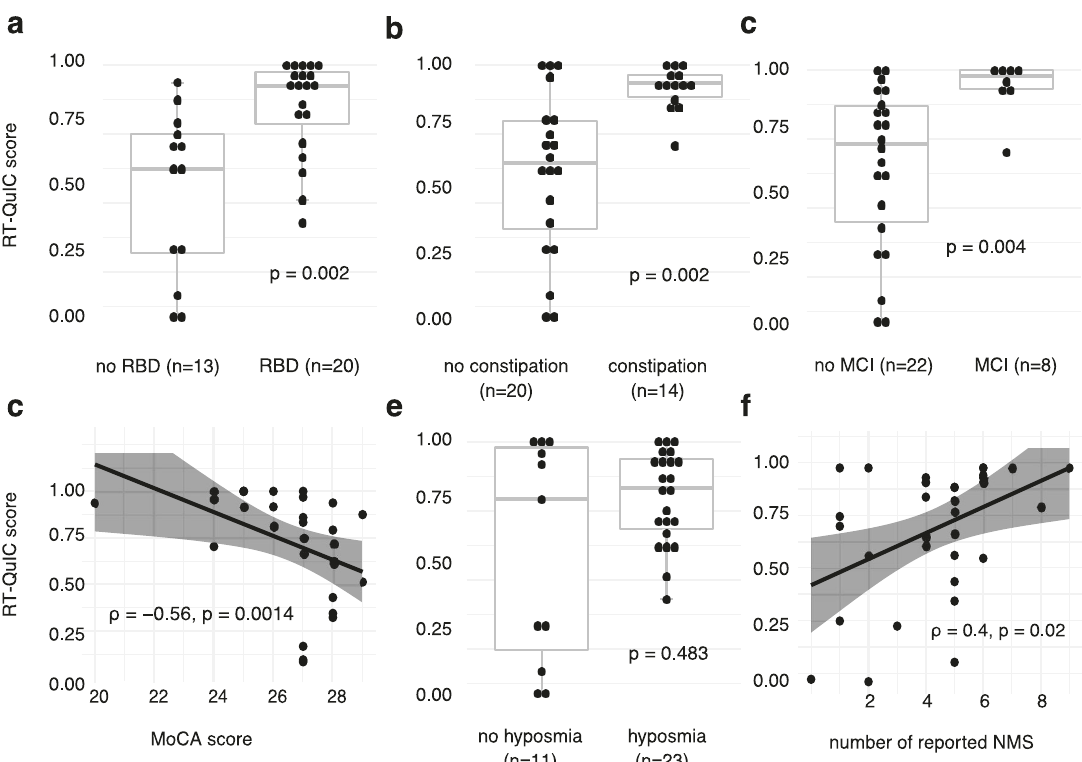
Fig. 6 Skin RT-QuIC scores correlate with non-motor symptom burden. a – c , e Box plots illustrating differences in skin RT-QuIC scores between subgroups reporting certain non-motor symptoms. Skin RT-QuIC scores (vertical axis: 0 – 1) pooled from both centers are higher in patients with possible RBD ( a ), constipation ( b ), and MCI ( c ). The skin RT-QuIC scores are not signi fi cantly higher in patients reporting hyposmia ( e ). The boxes represent the interquartile range (IQR), the middle line of each box indicates the median value with the median line and the whiskers extending to the most extreme data point, which is no more than 1.5 times of IQR. Values of individual patients are illustrated by dots. d , f Scatter plots illustrating correlations of skin RT-QuIC scores with non-motor symptoms. The skin RT-QuIC score negatively correlated with MoCA scores ( d ) and positively with the total number of reported key non-motor symptoms ( f ), respectively. A linear model regression line is shown, the gray shade represents the 95% con fi dence